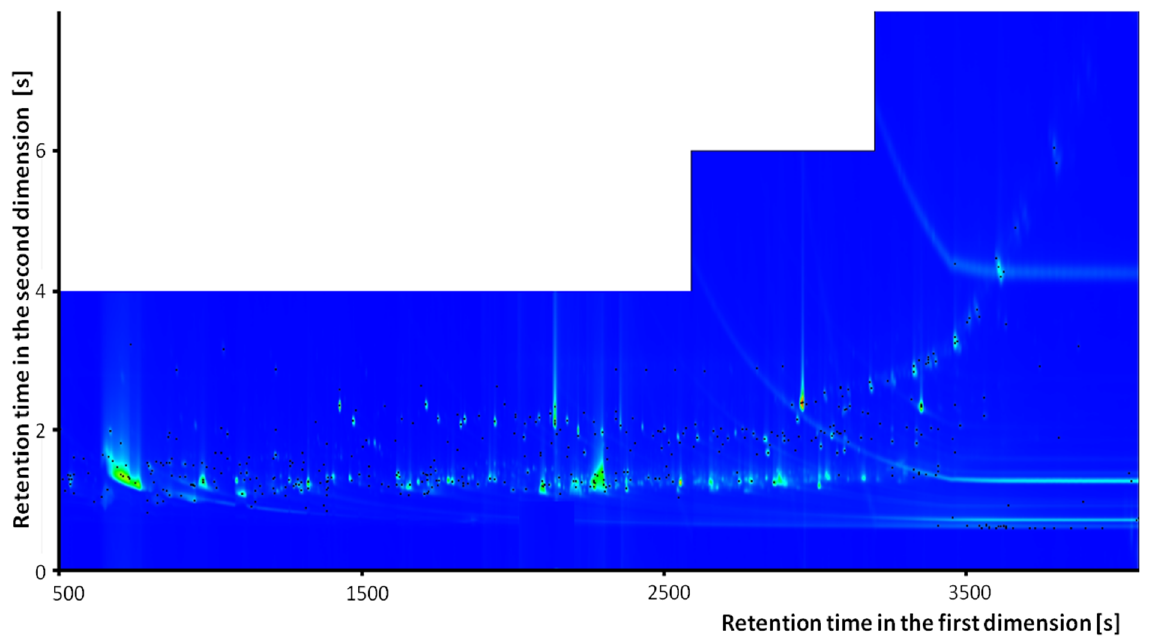
Figure 6. The TIC 2D chromatogram of the model mixture (composition see Table 1) measured under the conditions de- scribed in Section 2.4 on Rxi-17Sil MS (2 + 30 m) and TG-5HT (1 m) columns. The marked classification zones are the following: black ( n -alkanes), lower dark yellow (amines), upper dark yellow (amides), green (chloroalkanes), left white (alcohols), right white (ethers), yellow (aldehydes and ketones), left red (acids and esters), right red (esters of higher fatty acids), and unlabeled (others).